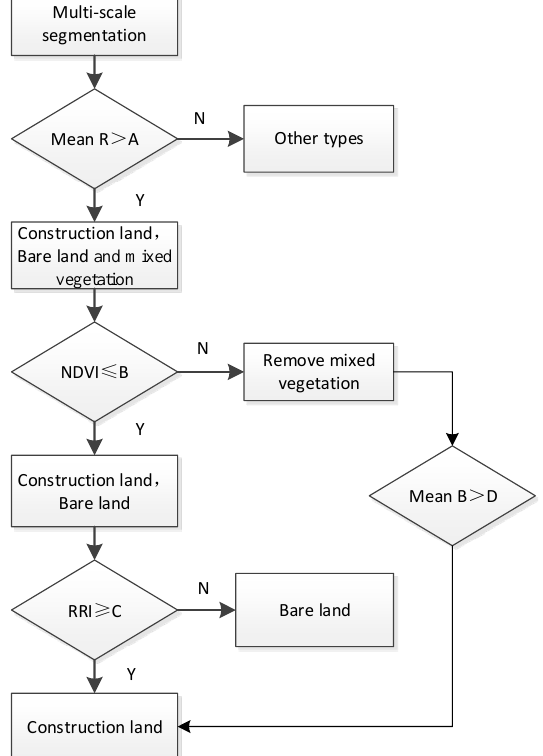
Figure 1. Technological process of construction land